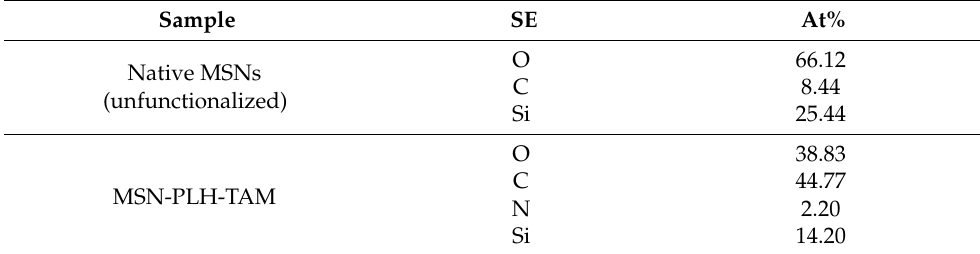
Figure 7. Survey XPS spectra of native MSN and MSN-PLH-TAM samples. The presence of nitrogen at ≈ 400 eV was observed in MSN-PLH-TAM sample, but not in native MSNs. Table 1. Survey XPS data of native MSNs vs.